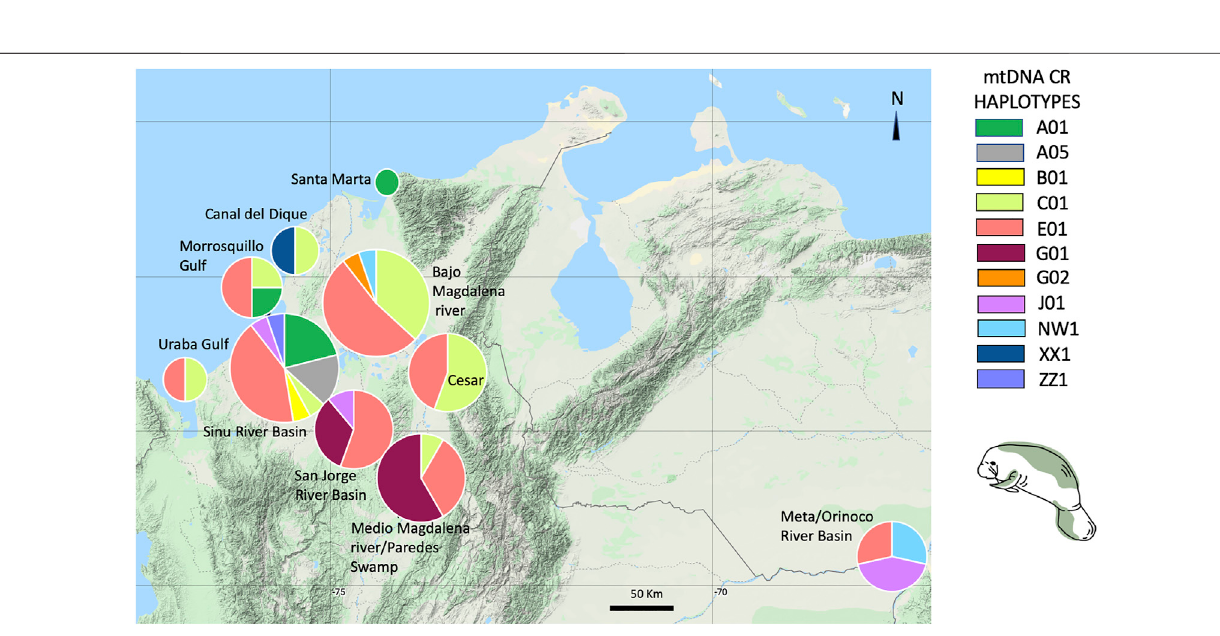
Frontiers in Genetics |